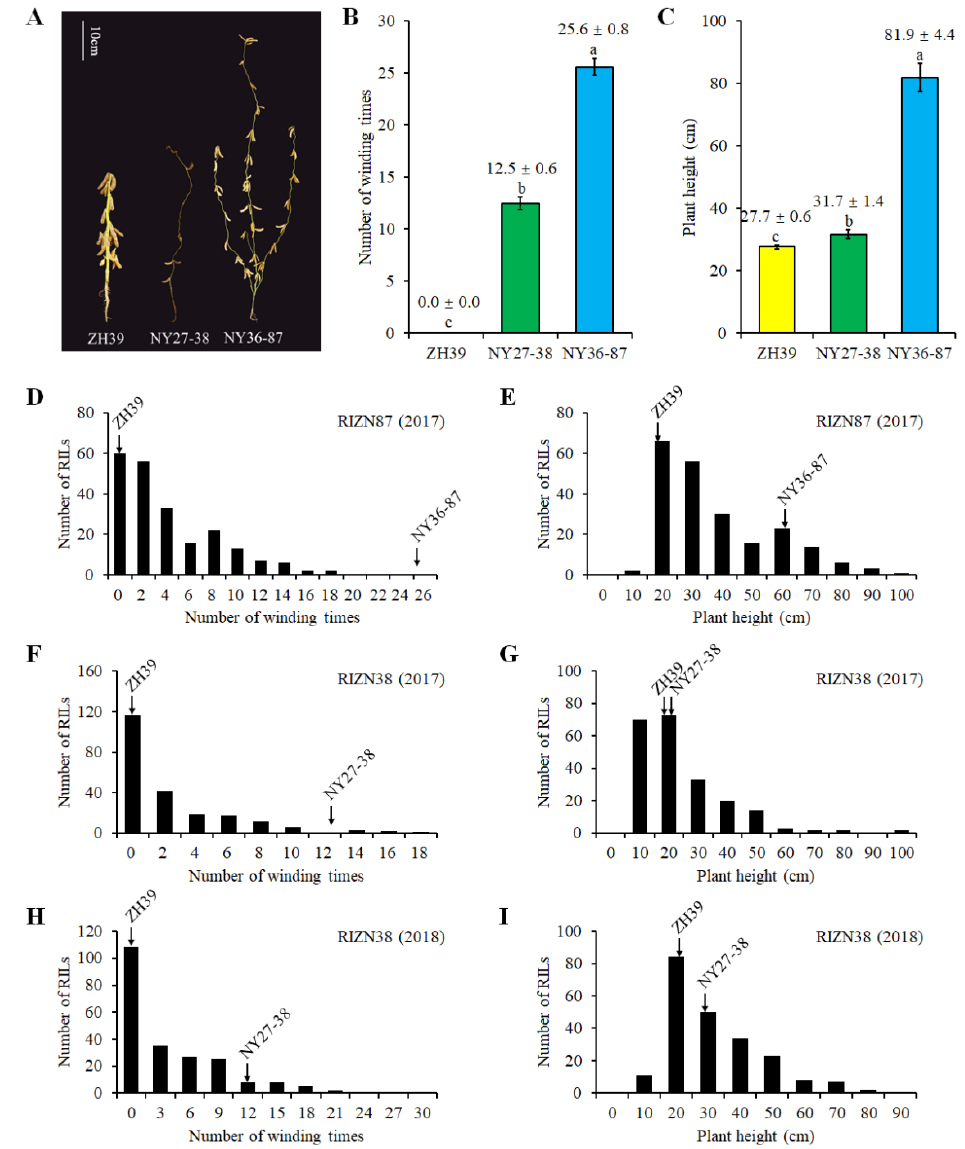
Figure 1. Phenotype and frequency distributions of the vining growth (VG) and plant height (PH) of RIL populations from crosses of ZH39 × NY36-87 ( n = 217) and ZH39 × NY27-38 ( n = 219). ( A ) ZH39, NY27-38 and NY36-87 phenotypes. The number of times plant stems wound themselves around a supporting structure ( B ) and the plant height ( C ) of ZH39, NY27-38 and NY36-87, n = 15. Different letters above the bars indicate significant differences between parents (one-way ANOVA followed by Fisher’s test, p < 0.05). The 2017 ( D ) VG and ( E ) PH data of an RIL population derived from ZH39 × NY36-87, the ( F ) 2017 and ( G ) 2018 VG data of a ZH39 × NY27-38 RIL population and the ( H ) 2017 and ( I ) 2018 plant height data of a ZH39 × NY27-38 RIL